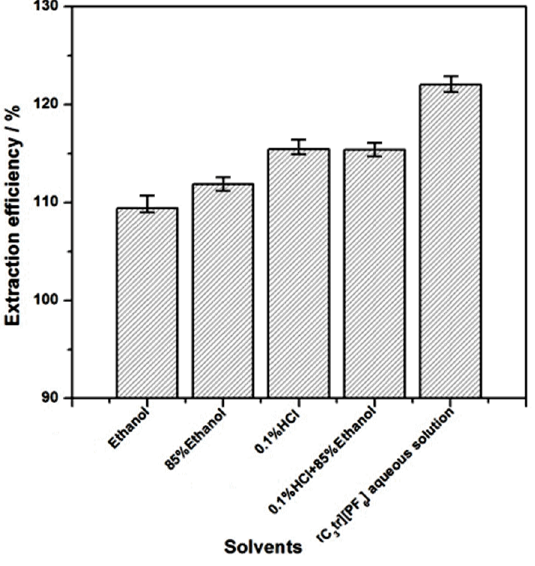
ffi ciency obtained by di ff erent Figure 4. Comparison on extraction efficiency obtained by different solvents. Figure 4. Comparison on extraction e